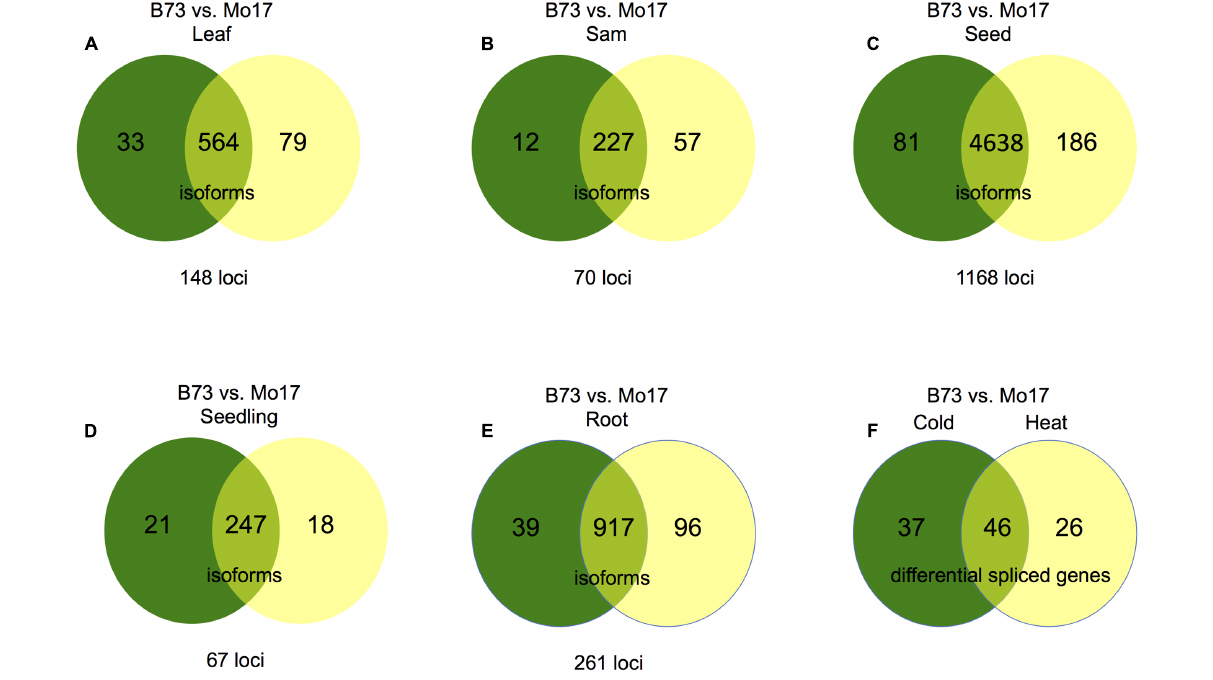
FIGURE 5 | Genotype specific AS between B73 and Mo17. For figures (A–E) numbers in the left portion of the Venn diagrams (green) represent isoforms absent in B73 but present in Mo17; numbers in the right portion of the Venn diagrams (yellow) represent isoforms absent in Mo17 but present in B73. Numbers in the overlap regions represent isoforms follow other patterns, but also in differentially spliced genes. (A) Differential AS between B73 and Mo17 in leaf tissue. (B) Differential AS between B73 and Mo17 in SAM tissue. (C) Differential AS between B73 and Mo17 in seed tissue. (D) Differential AS between B73 and Mo17 in seedling tissue. (E) Differential AS between B73 and Mo17 in root tissue. (F) Genes that undergo differential AS between B73 and Mo17 in response to cold and heat stress. The number of genes that are differentially spliced between Mo17 and B73 under cold stress that are not responsive to heat stress are presented on the left. The number of genes that are differentially spliced between Mo17 and B73 under heat stress that are not responsive to cold stress are presented on the right, The number of genes that are differentially spliced between Mo17 and B73 under both heat and cold stress are presented at the